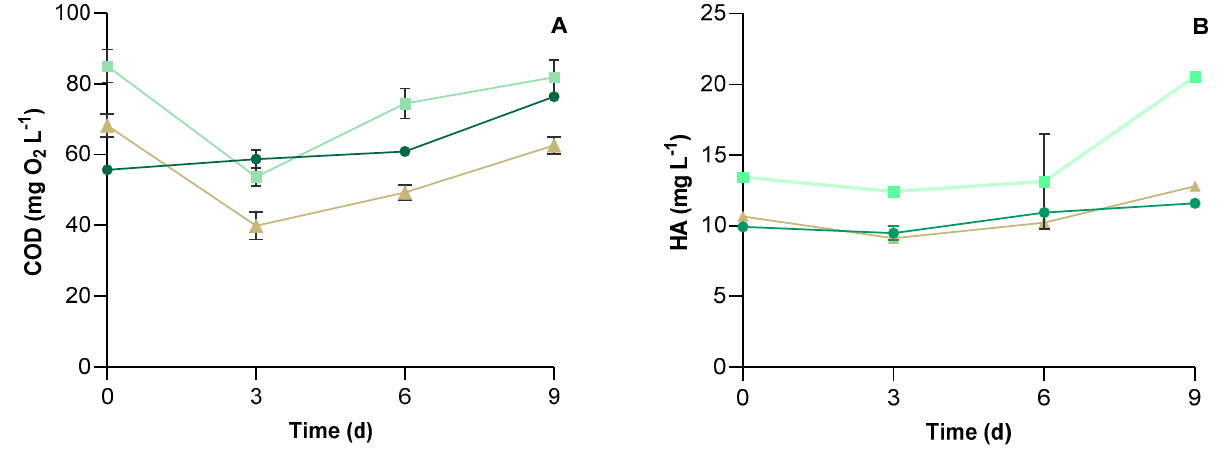
Figure 6. Variation of chemical oxygen demand (COD) ( A ) and humic acid (HA) ( B ) concentration (average ± standard deviation) over time (d), expressed in mg O 2 L − 1 and mg L − 1 , respectively, for each PBR: (cid:4) CV ( C. vulgaris + UWW); (cid:4) C+ ( C. vulgaris + autoclaved UWW); and (cid:4) C − (raw UWW).